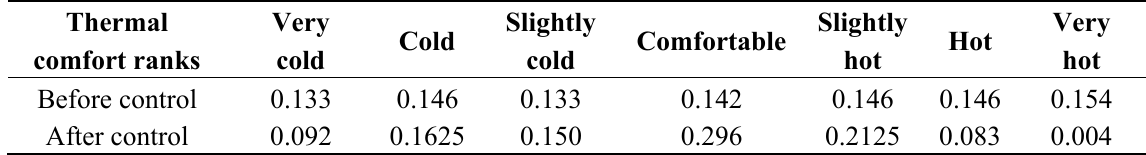
Figure 10. Thermal comfort rank distribution. Table 2. Thermal comfort rank distribution.